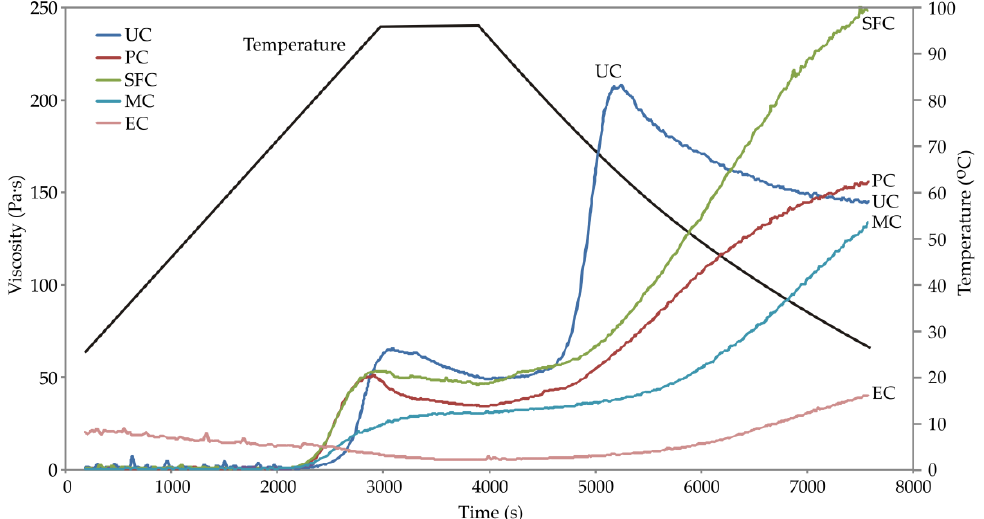
Figure 2. Pasting profiles of unprocessed and heat-treated corn samples (UC—unprocessed corn; PC—pelleted corn; SFC—steam-flaked corn; MC—micronized corn; EC—extruded corn).